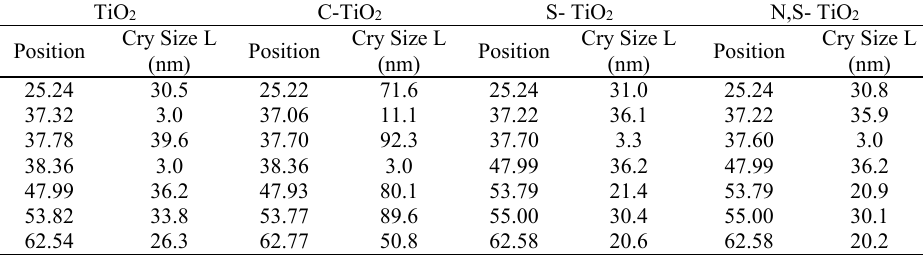
Table 1. Calculated crystal size of TiO Fig. (1): XRD patterns of TiO 2 , C-TiO 2, S-TiO 2 and C,S-TiO 2 NPs.